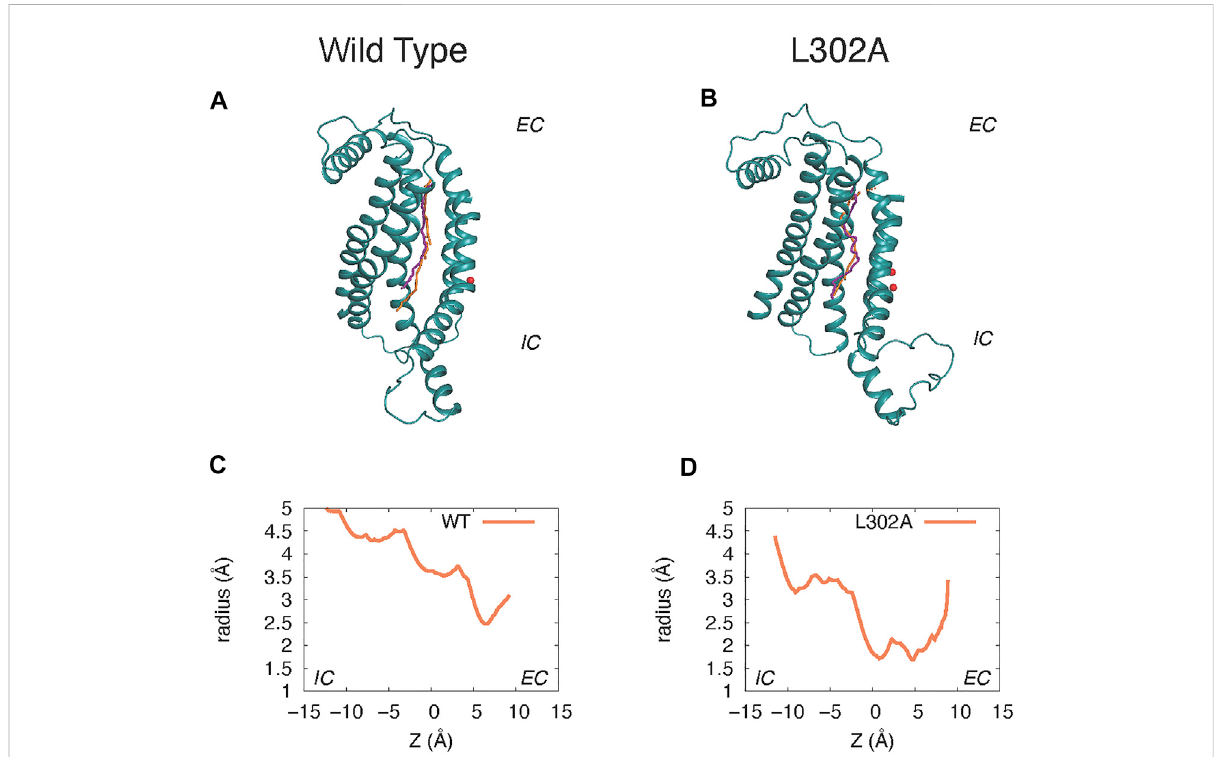
FIGURE 7 ComparisonofthegrooveaxisobtainedfromtheHolecalculationstothe “ averageK + trajectory ” obtainedbyaveragingtheXYpositionsofK + at eachZvalueintheumbrellasamplingcalculations.Panels (A) and (C) arefromSystem2calculationsofthewildtypenhTMEM16ina3:1POPE/POPG membrane.Panels (B) and (D) arefromparallelsimulationsofthenhTMEM16-L302Amutant.ThegrooveaxiscalculatedwiththeHOLEsoftwareisin orange, and the K + trajectory in purple. For simplicity, only the protein region composed of the TM3 – TM7 helices is shown (rendered in teal cartoon), and Ca 2+ ions are shown as red spheres. Panels (C) and (D) show the radius of the pore along the pathway calculated with the HOLE software as described